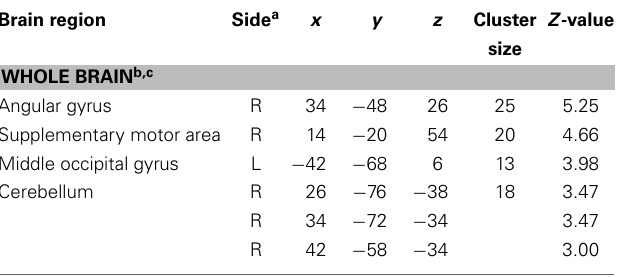
a L, left hemisphere; R, right hemisphere.